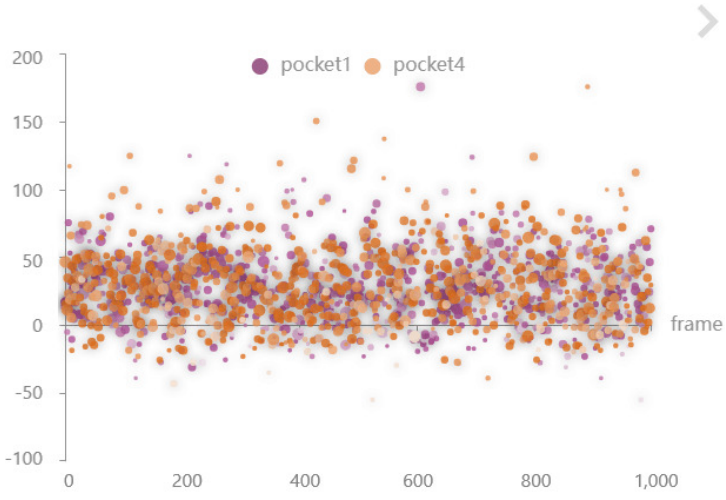
Figure 11. The contrast scatter plot between pocket 1 and pocket 4 at 1000 timesteps, the size of the dot represents the pocket volume, the x-axis coordinate of the dot represents the hydrophilicity of the pocket, transparency of dots indicates pocket